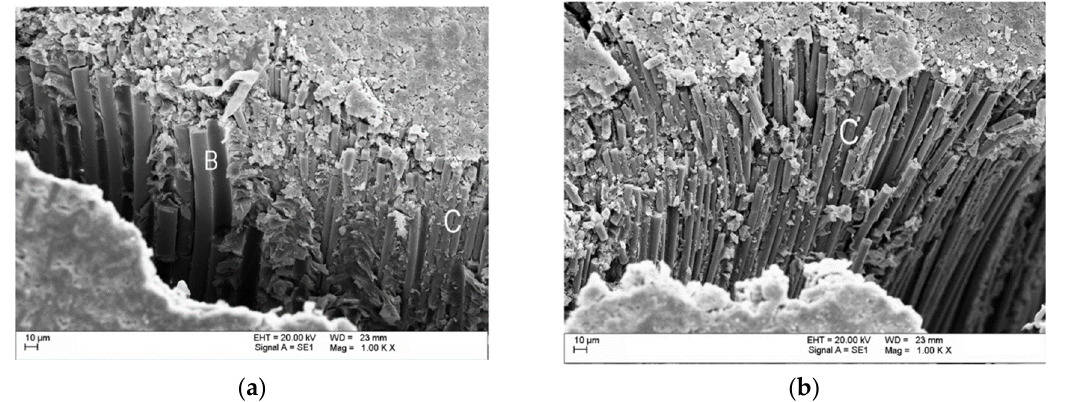
Figure 5. HFRP bar with a diameter of 8 mm: ( a ) Visible broken basalt (B) and carbon (C) fibers; ( b ) micro-buckling with broken carbon fibers (C); (own research).